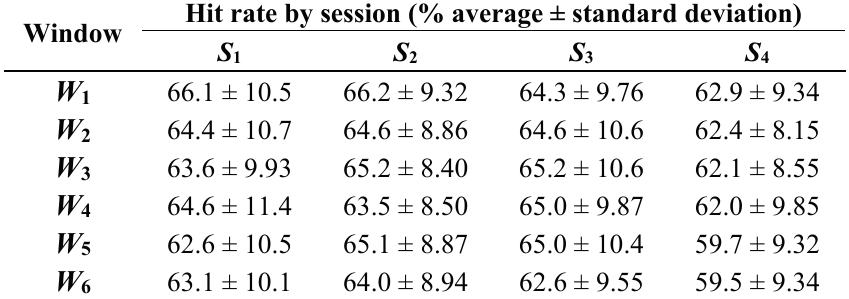
Table 3. Average hit rates with the NB classifier using all CSP channels and channels C3, C4, P3 and P4 to estimate W